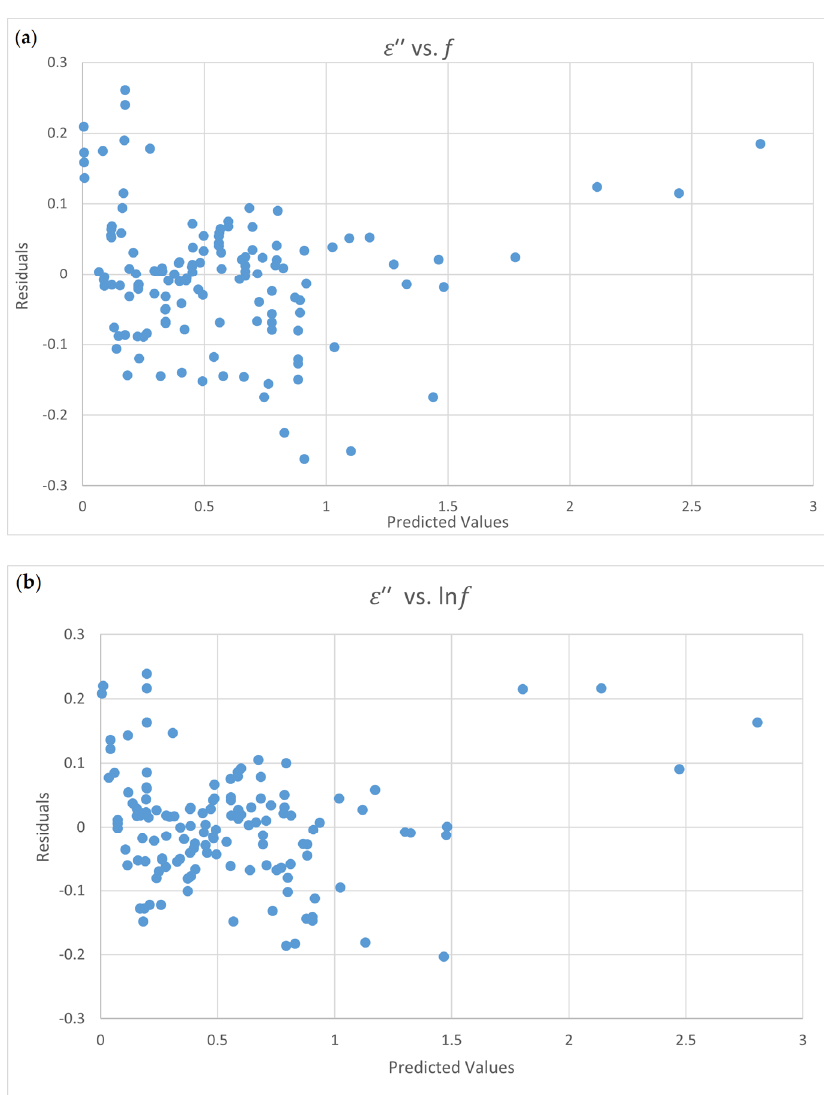
Figure 3. Residual plots for the loss factor ε’’ equation for egg white power (Boreddy and Subbich data [8]); ( a ). ε (cid:48)(cid:48) vs. f ; ( b ). ε (cid:48)(cid:48) vs. ln f